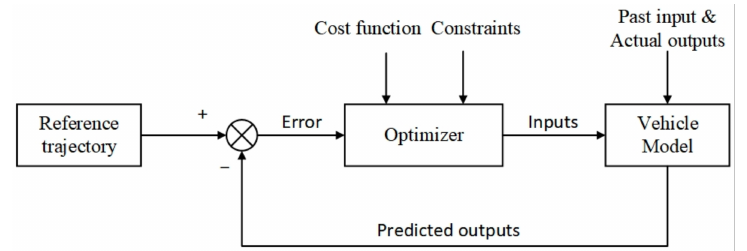
Figure 2. General framework of an MPC